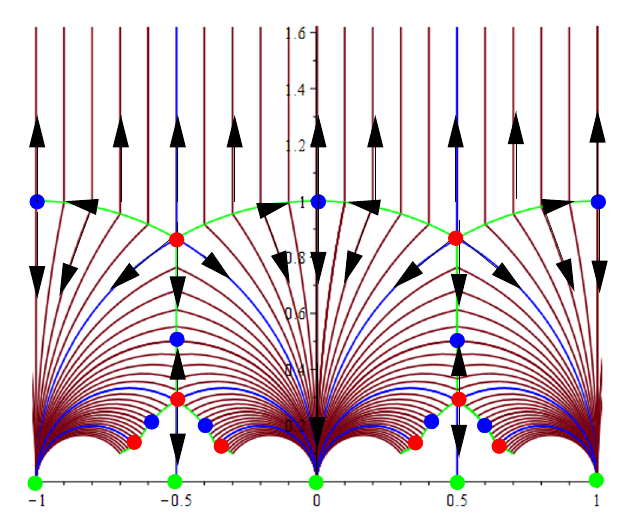
Figure 1 . Temperature flow of the conductivity on the event horizon obtained from tiling the upper-half conductivity plane, replicating the fundamental domain using Γ(1) symmetry (arrows in direction of decreasing temperature). The green lines indicate phase boundaries, blue circles are saddle points and the red circles are purely repulsive fixed points. Green circles are purely attractive fixed points as T → 0 (there are attractive fixed points at every rational number on the real axis, but only half-integral values are shown in the figure). The vertical strip − 1 green circular arc between e − iπ/ 3 and e iπ/ 3 , bounded by the vertical blue lines, is a fundamental domain of Γ(1)